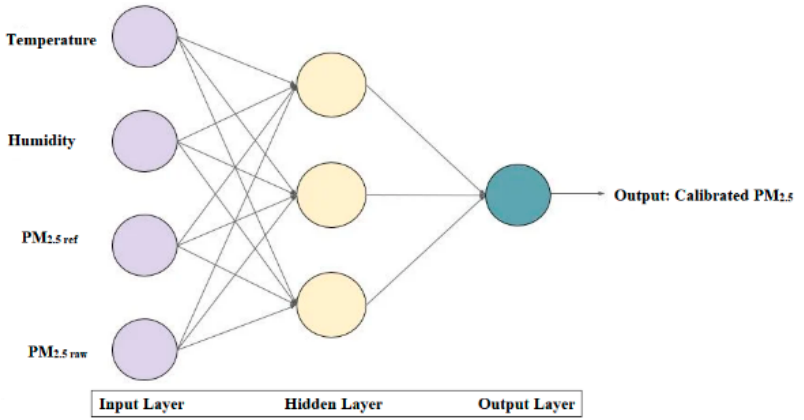
Figure 8. Block diagram of the Multi-Layer Perceptron model.